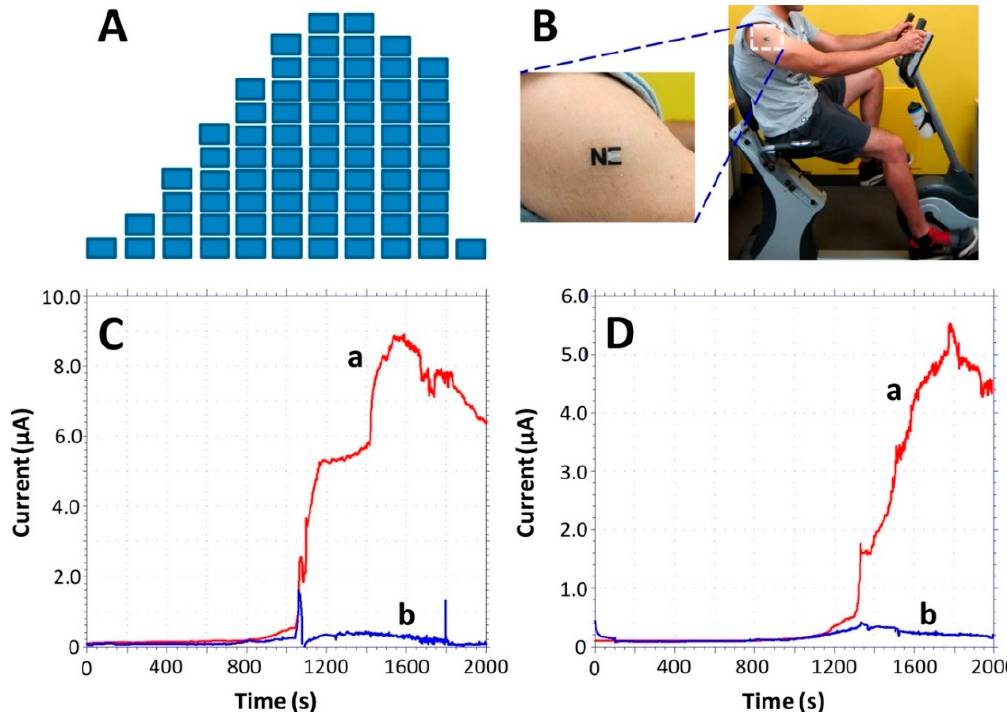
Figure 5. Monitoring of sweat lactate during 33 min of cycling exercise while adjusting the work intensity. ( A ) Exercise resistance profile on a stationary cycle. Subjects were asked to maintain a constant cycling rate while the resistance was increased every 3 min for a total evaluation of 30 min. A 3-min cool down period followed the exercise. ( B ) An “NE” lactate biosensor applied to a male volunteer’s deltoid; ( C , D ) Response of the LOx- (a) and enzyme-free (b) tattoo biosensors during the exercise regimen (shown in part A) using two representative subjects. Constant potential, 0.05 V (vs. Ag | AgCl); measurement intervals, 1 s. Reproduced from [140] with permission from the American Chemical Society.